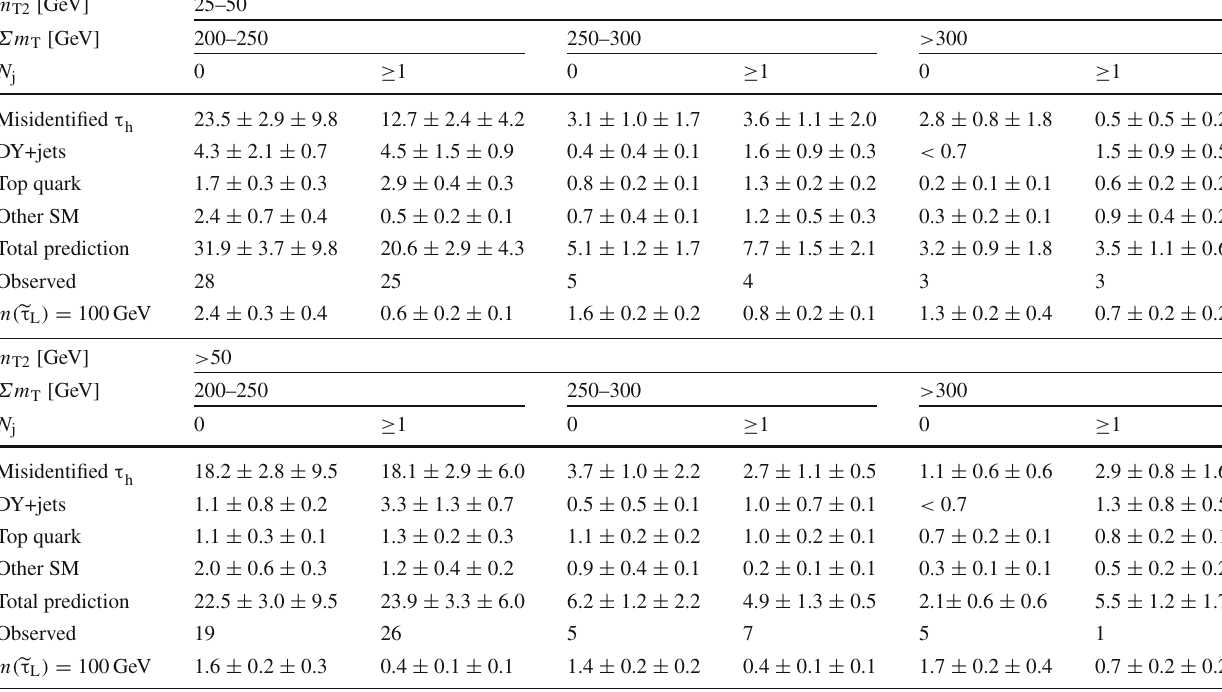
Table 3 Predicted background yields and observed event counts in τ τ SRs in 2016 data. For the background estimates with no events h h in the sideband or in the simulated sample, we calculate the 68% CL upper limit on the yield. The first and second uncertainties given are